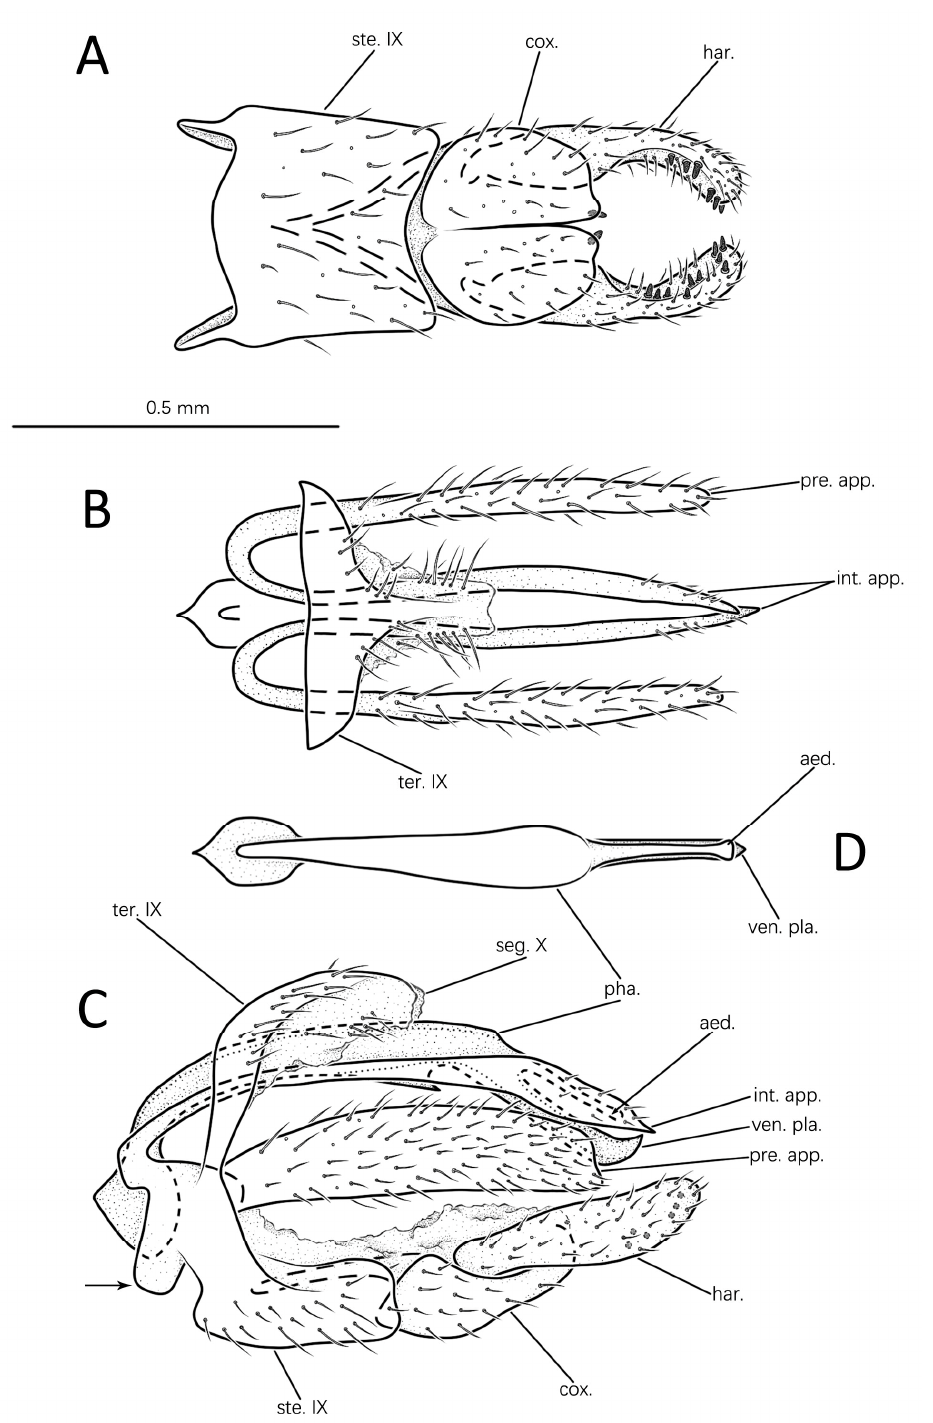
Figure 6. Male genitalia of Eoneureclipsis gei sp. nov.: ( A ) ventral; ( B ) dorsal; ( C ) left lateral; ( D ) phallic apparatus, dorsa. Abbreviations: ste. IX = sternum IX; ter. IX = tergum IX; seg. X = segment X; pre. app. = preanal appendages (paired); int. app. = intermediate appendages (paired); cox. = coxopodite (paired); har. = harpago (paired); pha. = phallic apparatus; aed. = aedeagus; ven. pla. = ventral